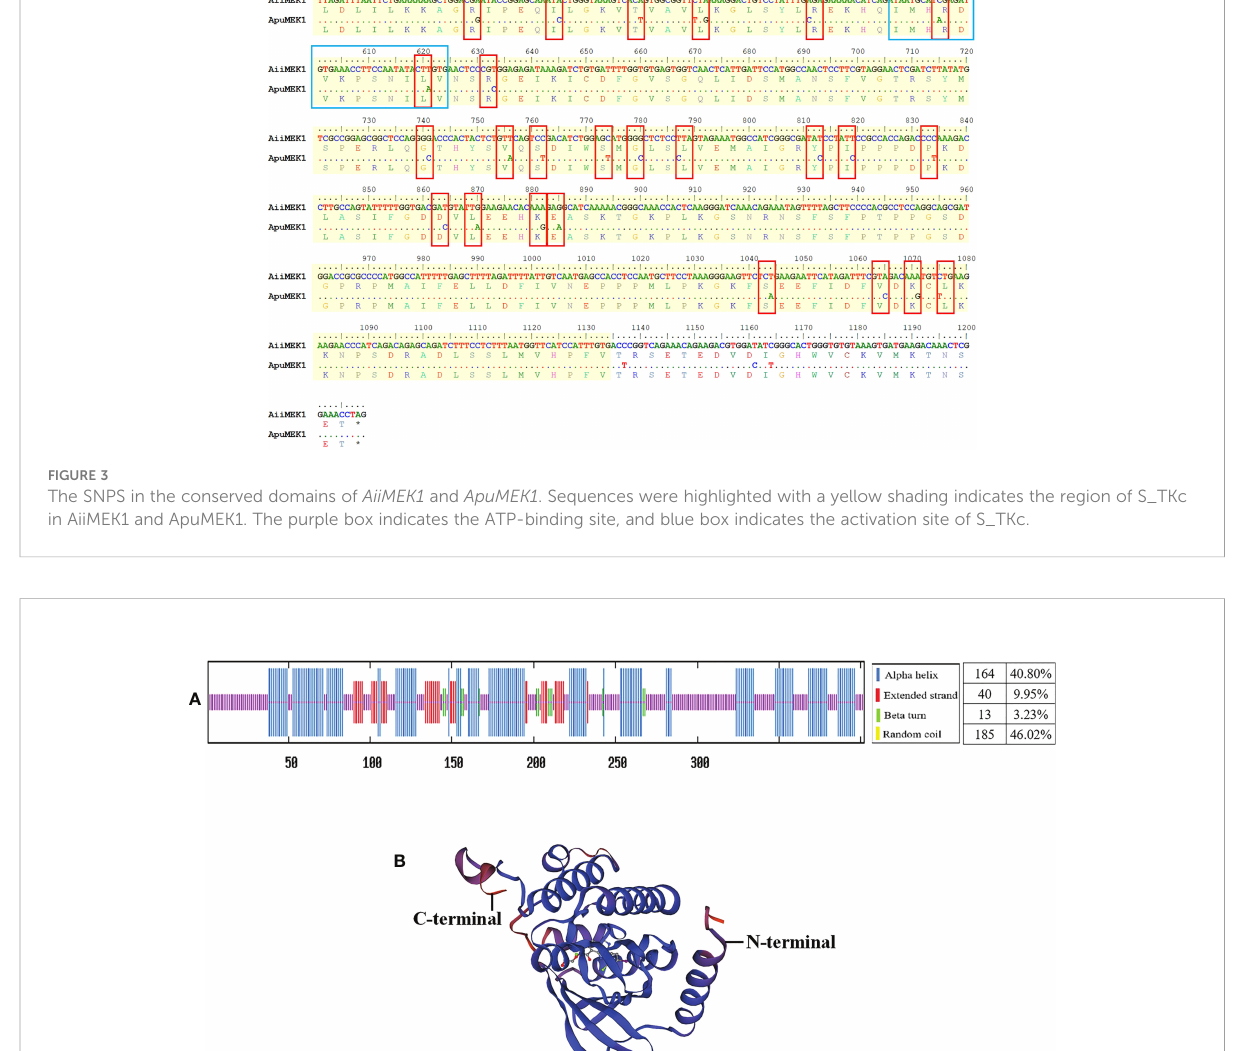
FIGURE 4 The secondary structures (A) and tertiary structures (B) of AiiMEK1 and